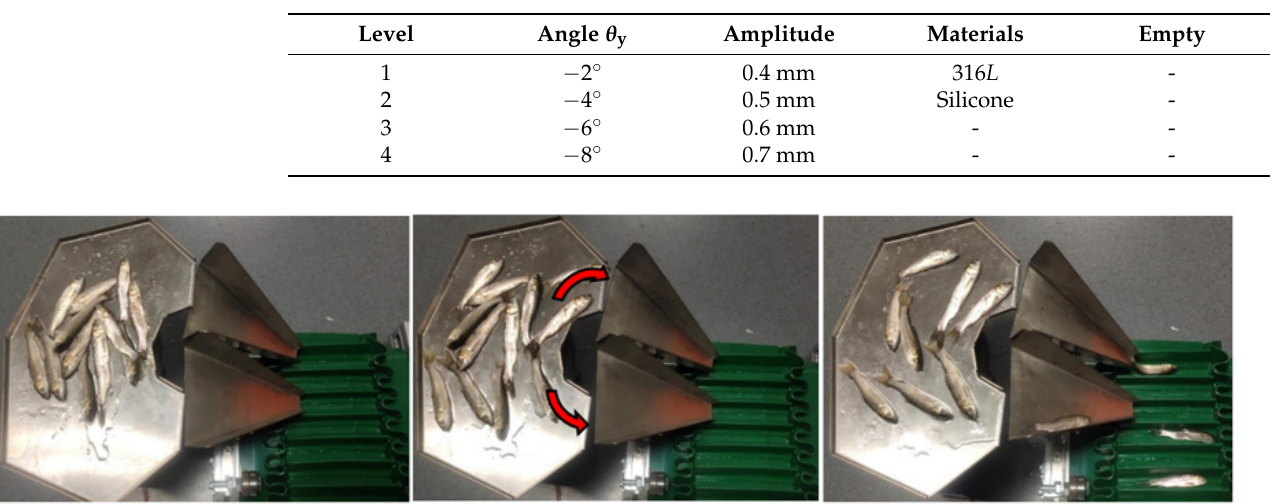
Table 3. Experimental protocol and